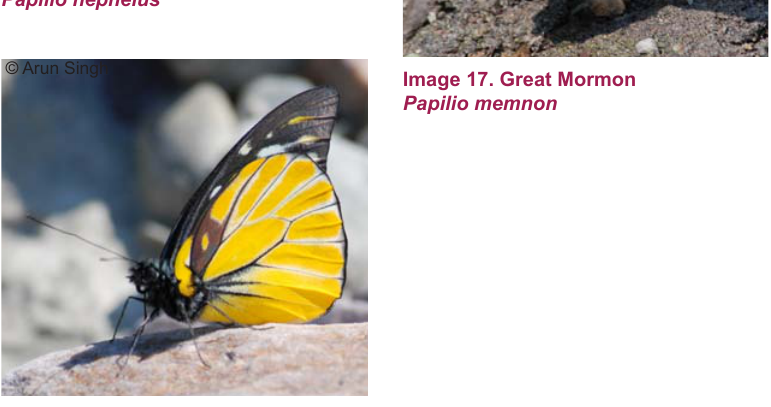
Image 18–20. Great Orange Tip, Hebomoia glaucippe , Yellow Orange Tip, Ixais pyrene and Chocolate Albatross, Appias lyncida